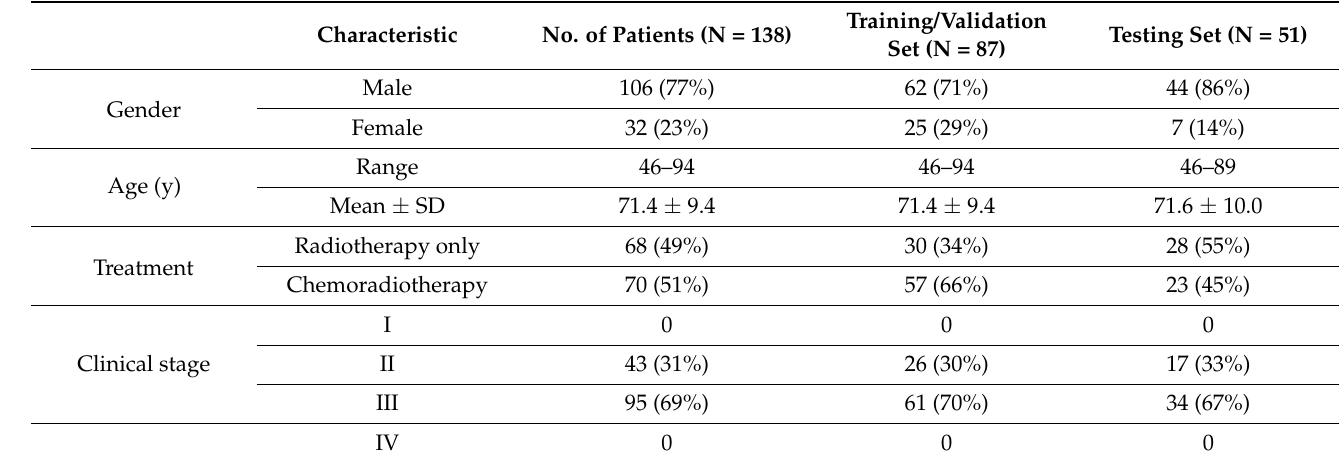
Table 1. Patients’